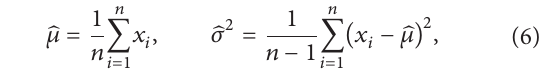
Figure 6: Image after fusion based on PCA.